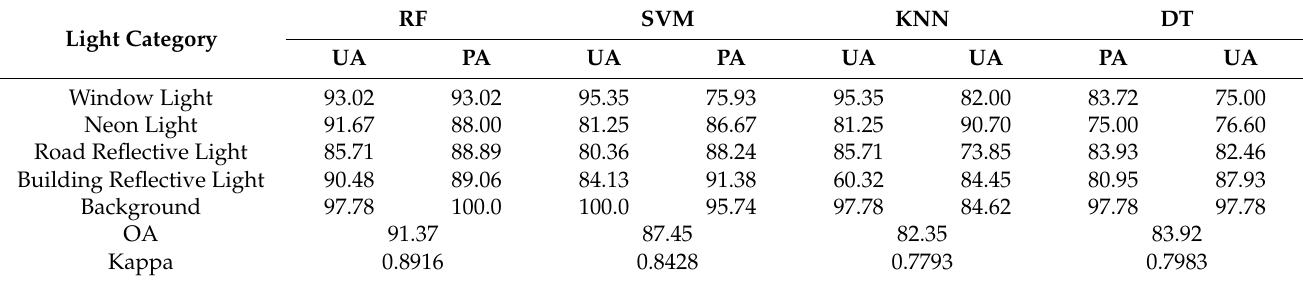
Table 7. Near view region classification accuracy table